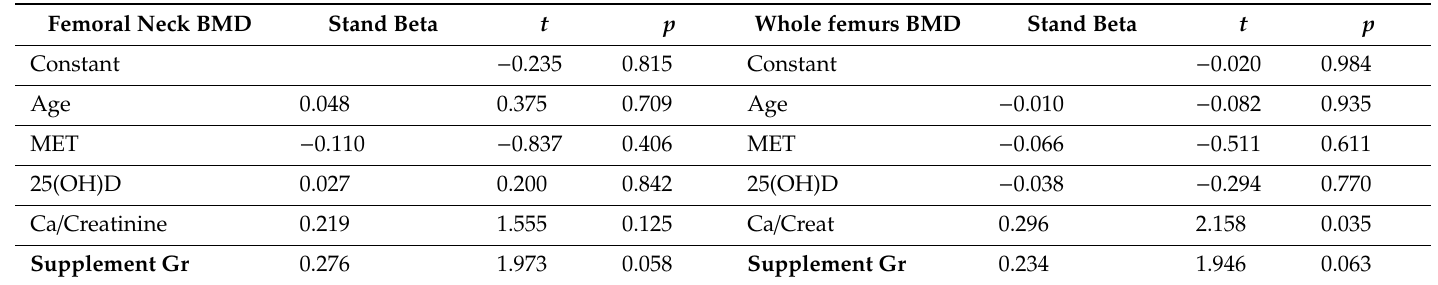
Table 5. Predicting change from baseline to 6 months using Supplement group ( n = 45) compared to Control group ( n = 41) for total body and lumbar spine BMD and confounders: age, metabolic equivalent (MET), serum 25 hydroxy vitamin D and urinary Ca / Creatinine at